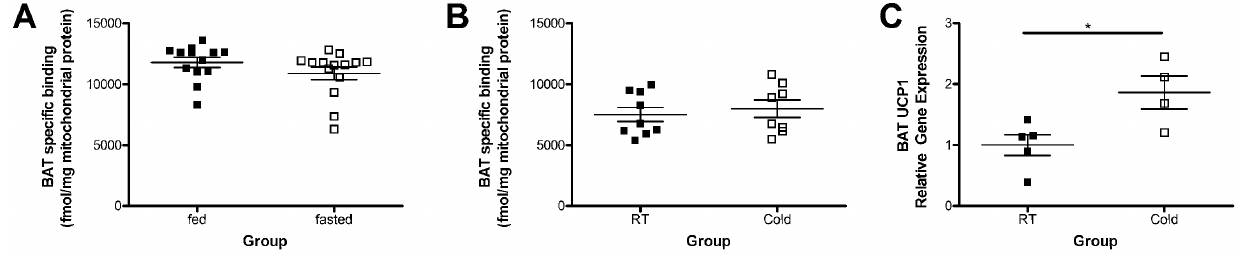
Figure 6. TSPO is not regulated in brown adipose tissue by fasting or cold exposure. Binding of TSPO ligand 3 H-PK11195 in brown adipose tissue (BAT) mitochondrial extracts from mice fasted for 17 hours (A; n=13–14) or exposed to 4–8 u C for 4 hours (B; n=8–9) revealed no significant differences in specific binding when compared to the fed ( p =0.1853) or room temperature (RT; p =0.6163) control animals for each group respectively, as determined by unpaired t-test. BAT UCP1 mRNA was significantly increased in mice exposed to 4–8 u C for 4 hours as compared to their control animals maintained at room temperature (C; n=5/group). Data are expressed as mean 6 standard error. * p , 0.05 was determined by unpaired